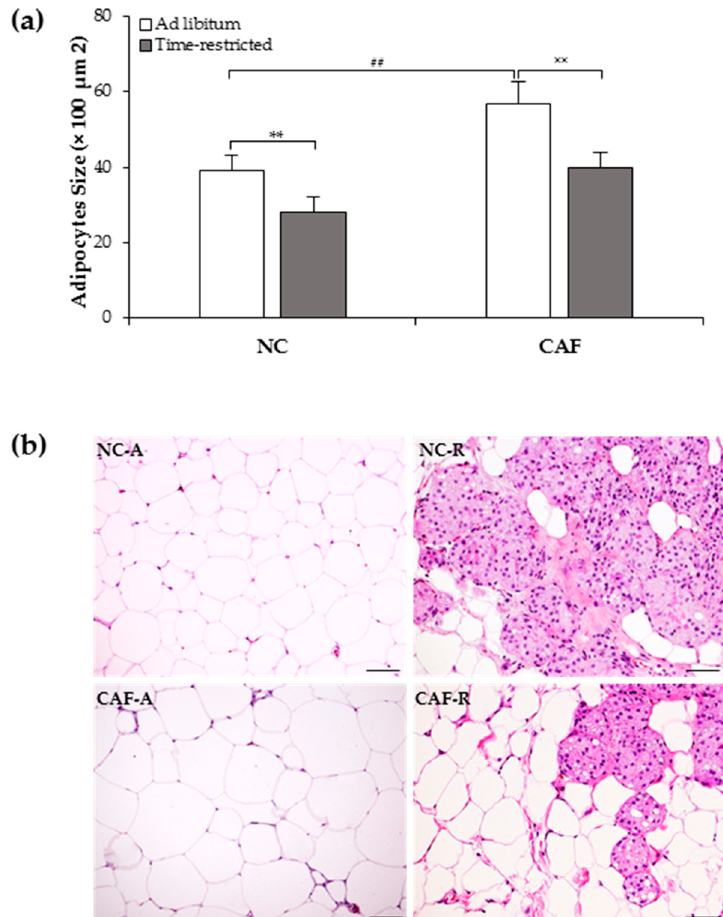
Figure 3. E ff ect of time-restricted feeding on inguinal WAT morphology of normal-chow- and cafeteria-fed rats: ( a ) mean adipocyte area was measured using a morphometric quantitative method at × 200 magnification with Axio Vision software; ( b ) representative hematoxylin and eosin staining of inguinal WAT sections (original magnification × 400): time-restricted feeding regimen